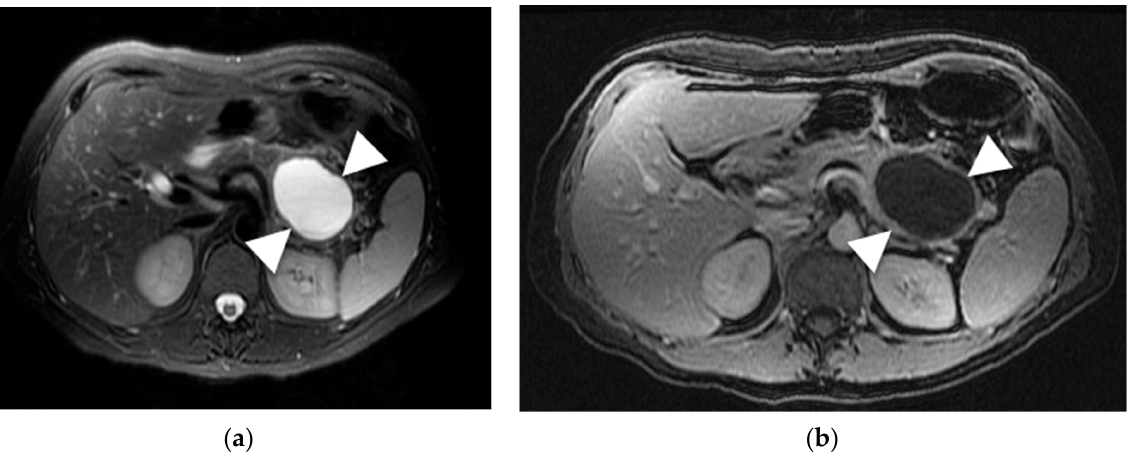
Figure 3. MCN. Middle-aged female with incidental pancreatic lesion. ( a ) Axial T2-weighted images demonstrate a pancreatic tail lesion (arrowheads) with high signal on the T2-weighted image, indicating fluid content and cystic nature. ( b ) T1-weighted post IV contrast image shows low signal centrally, indicating lack of solid enhancing component.